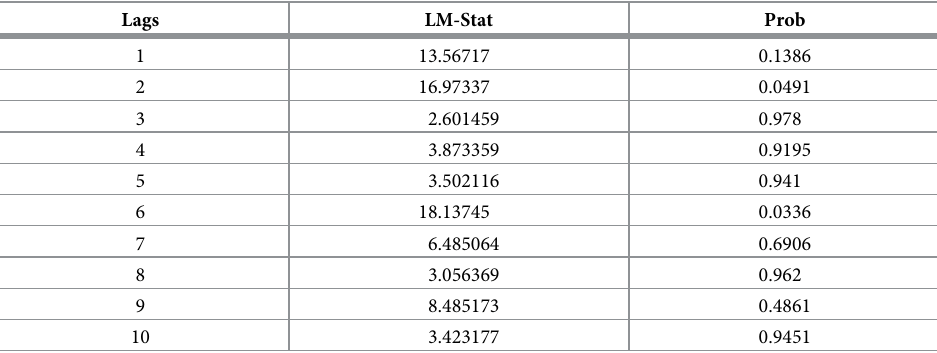
Table 8. Serial correlation LM test for Japanese data when P = 1 (proposed model).